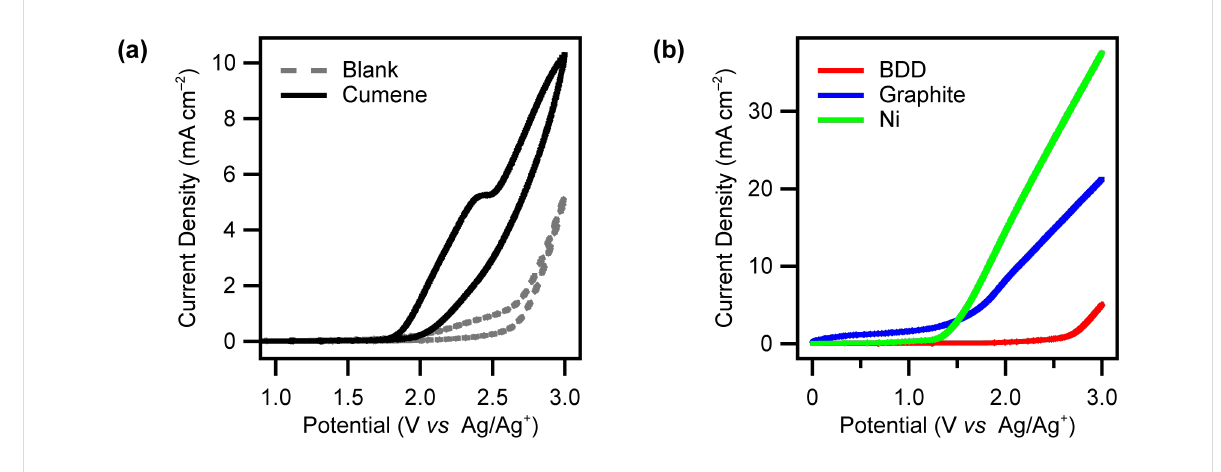
Figure 1: (a) Cyclic voltammograms of a BDD electrode in MeCN solution containing cumene ( 1 ; 5 mM) and Et 4 NClO 4 (0.1 M). The gray dashed line shows the voltammogram in the solution without cumene. (b) Linear sweep voltammograms of BDD (red), graphite (blue), and Ni (green) electrodes in